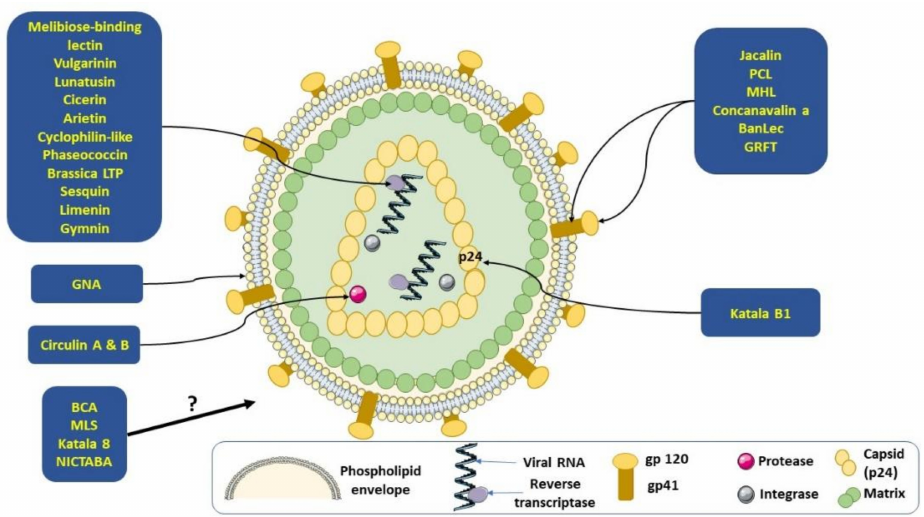
Figure 1. Melibiose-binding lectin, vulgarinin, lunatusin, cicerin, arietin, cyclophilin-like, phaseococ- cin, brassica LTP, sesquin, limenin, and gymnin inhibit the reverse transcriptase of HIV; circulin A & B inhibit the protease of HIV; katala B1 inhibits p24 capsid protein; jacalin, PCL, MHL, concanavalin a, BanLec, and GRFT inhibit HIV attachment through blocking the viral receptor (gp120/gp41); GNA targets the envelope glycoproteins of HIV-1; BCA, MLS, katala 8, and NICTABA possess anti-HIV activity but the mechanism is not yet